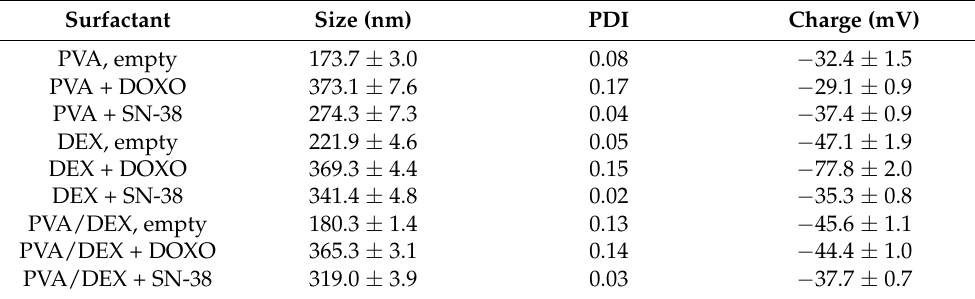
Surfactant Table 1. Average size (nm), PDI value and charge (mV) for the NPs prepared using the different surfactants, empty and loaded with either DOXO or SN-38.